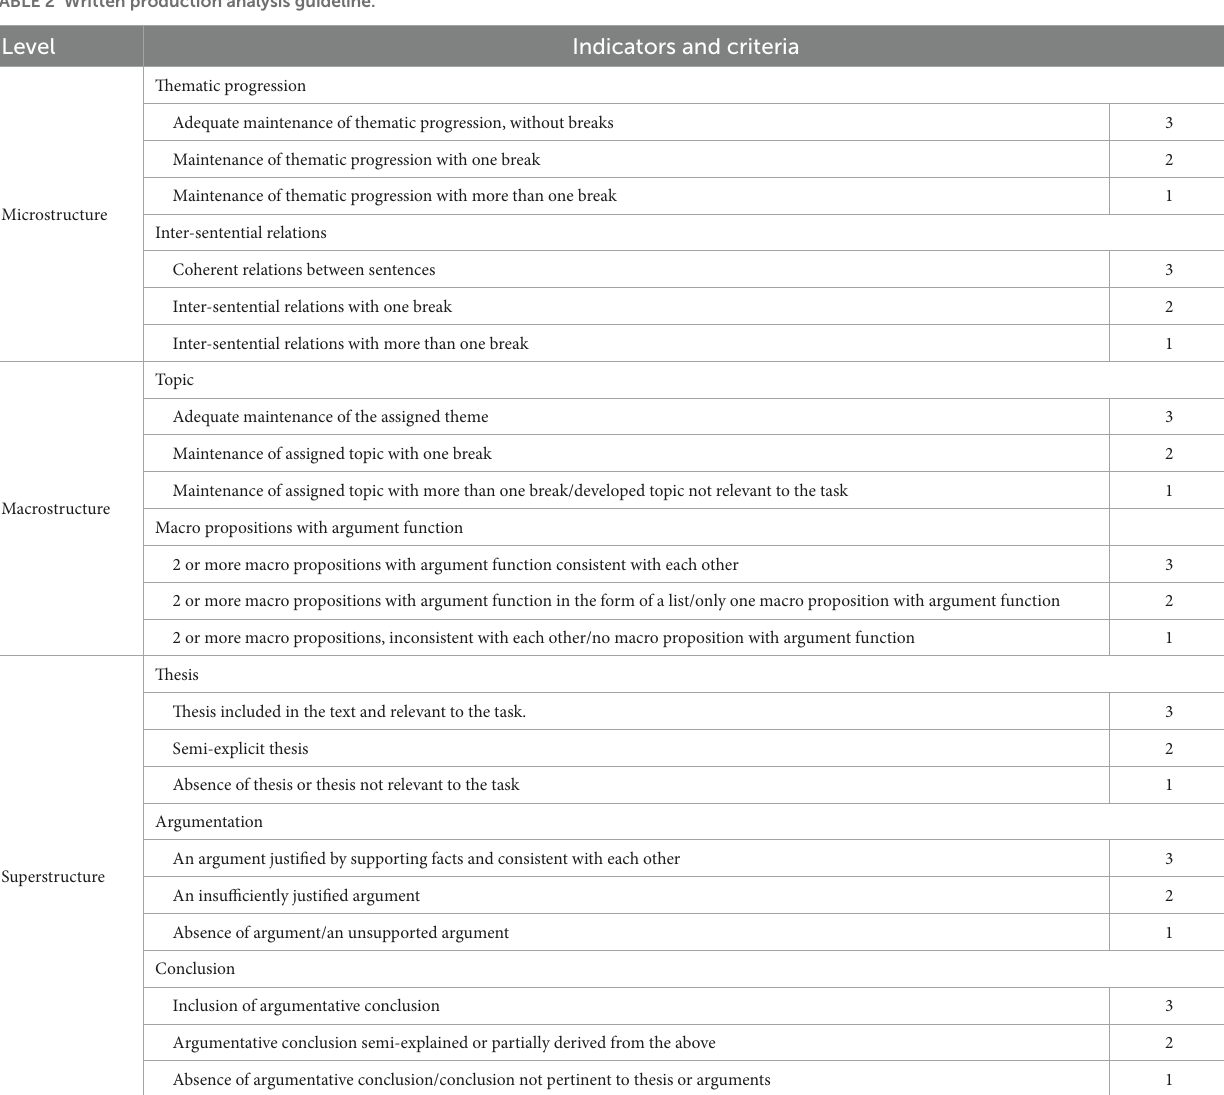
TABLE 2 Written production analysis